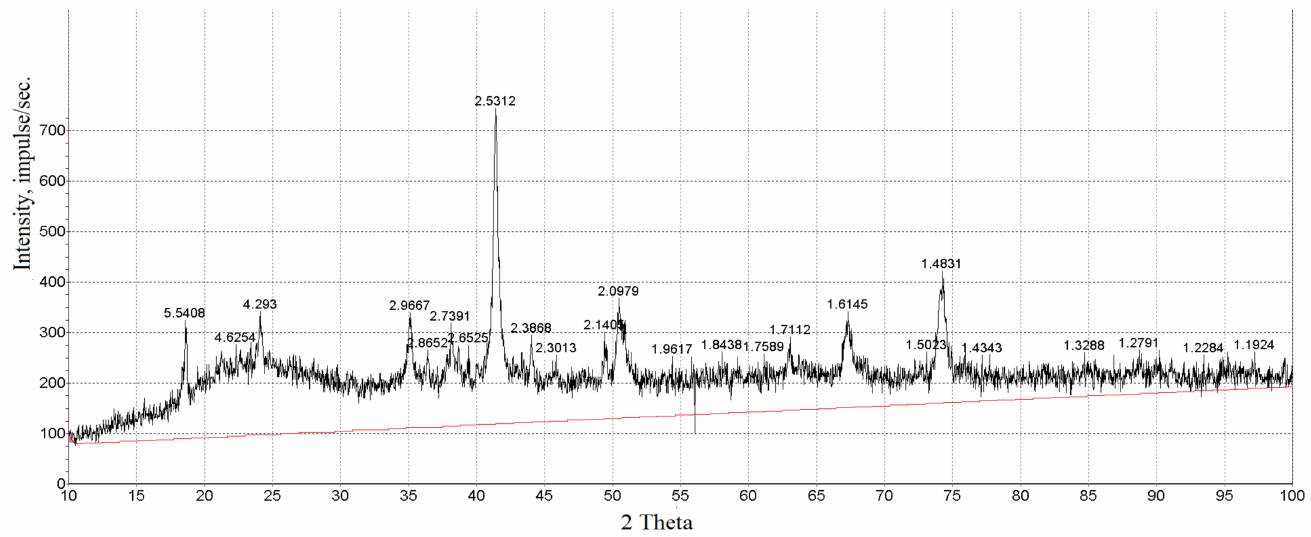
Figure 8. X-ray diffraction pattern of CoFe 2 O 4 /PEI composite.